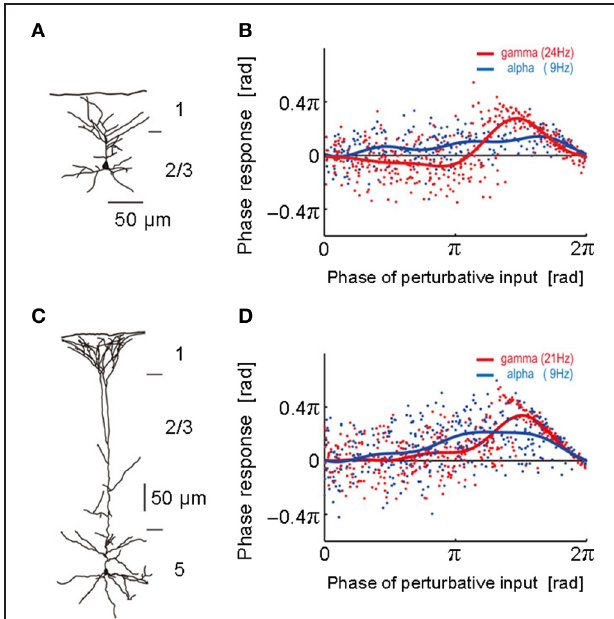
FIGURE 1 | Phase response curves obtained from different layers. (A) The morphological structure of a layer 2/3 pyramidal neuron was reconstructed. (B) Phase response curves obtained in the alpha (blue; 9Hz) and gamma (red; 24Hz) frequency ranges of the neuron described in (A) . The abscissa represents the phase at which the neuron was stimulated by a perturbative input and the ordinate the phase response to it. Each dot represents a noisy phase response to a stimulus. Blue and red solid curves display the average PRC obtained by the least-mean-square method. (C,D) The morphological structure of a layer 5 pyramidal neuron and its phase response curves obtained in the alpha (blue; 9Hz) and gamma (red; 21Hz) frequency ranges. [Modified from Tsubo et al. (2007a)].